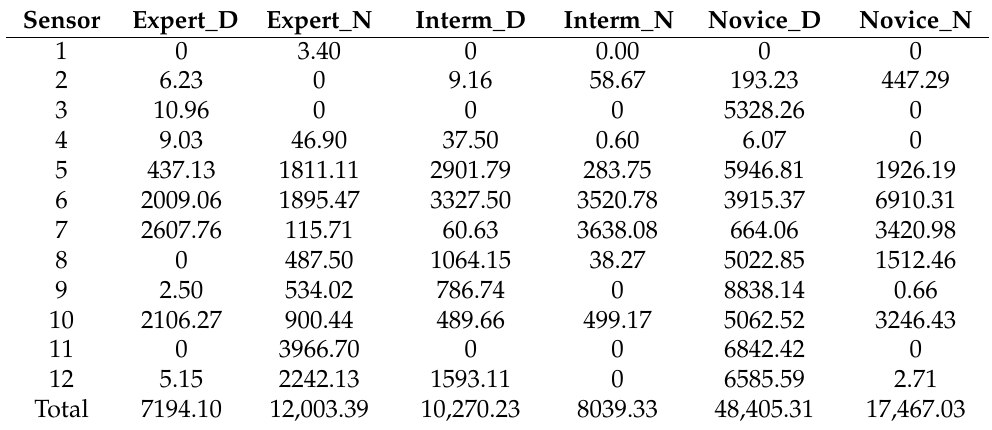
Table 6. Total force across sessions for each sensor (V).